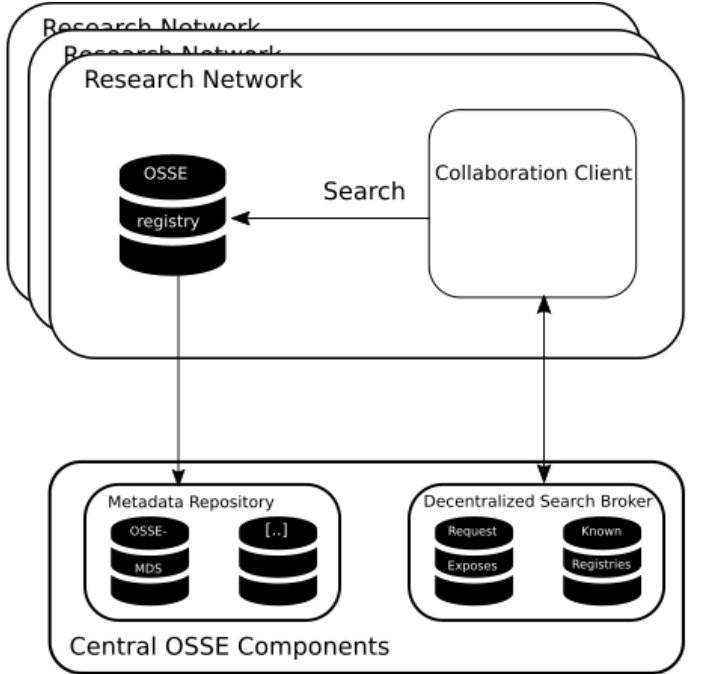
Figure 1. This illustration shows the different components of the OSSE and how they work together. Each registry, based on the OSSE metadata repository (MDS), models its data. The decentralized search broker publishes search inquiries to all selected known registries. Finally, the collaboration client of the selected registries searches for matching data. OSSE: Open Source Registry System for Rare Diseases ( Open-Source-Registersystem für Seltene Erkrankungen , in